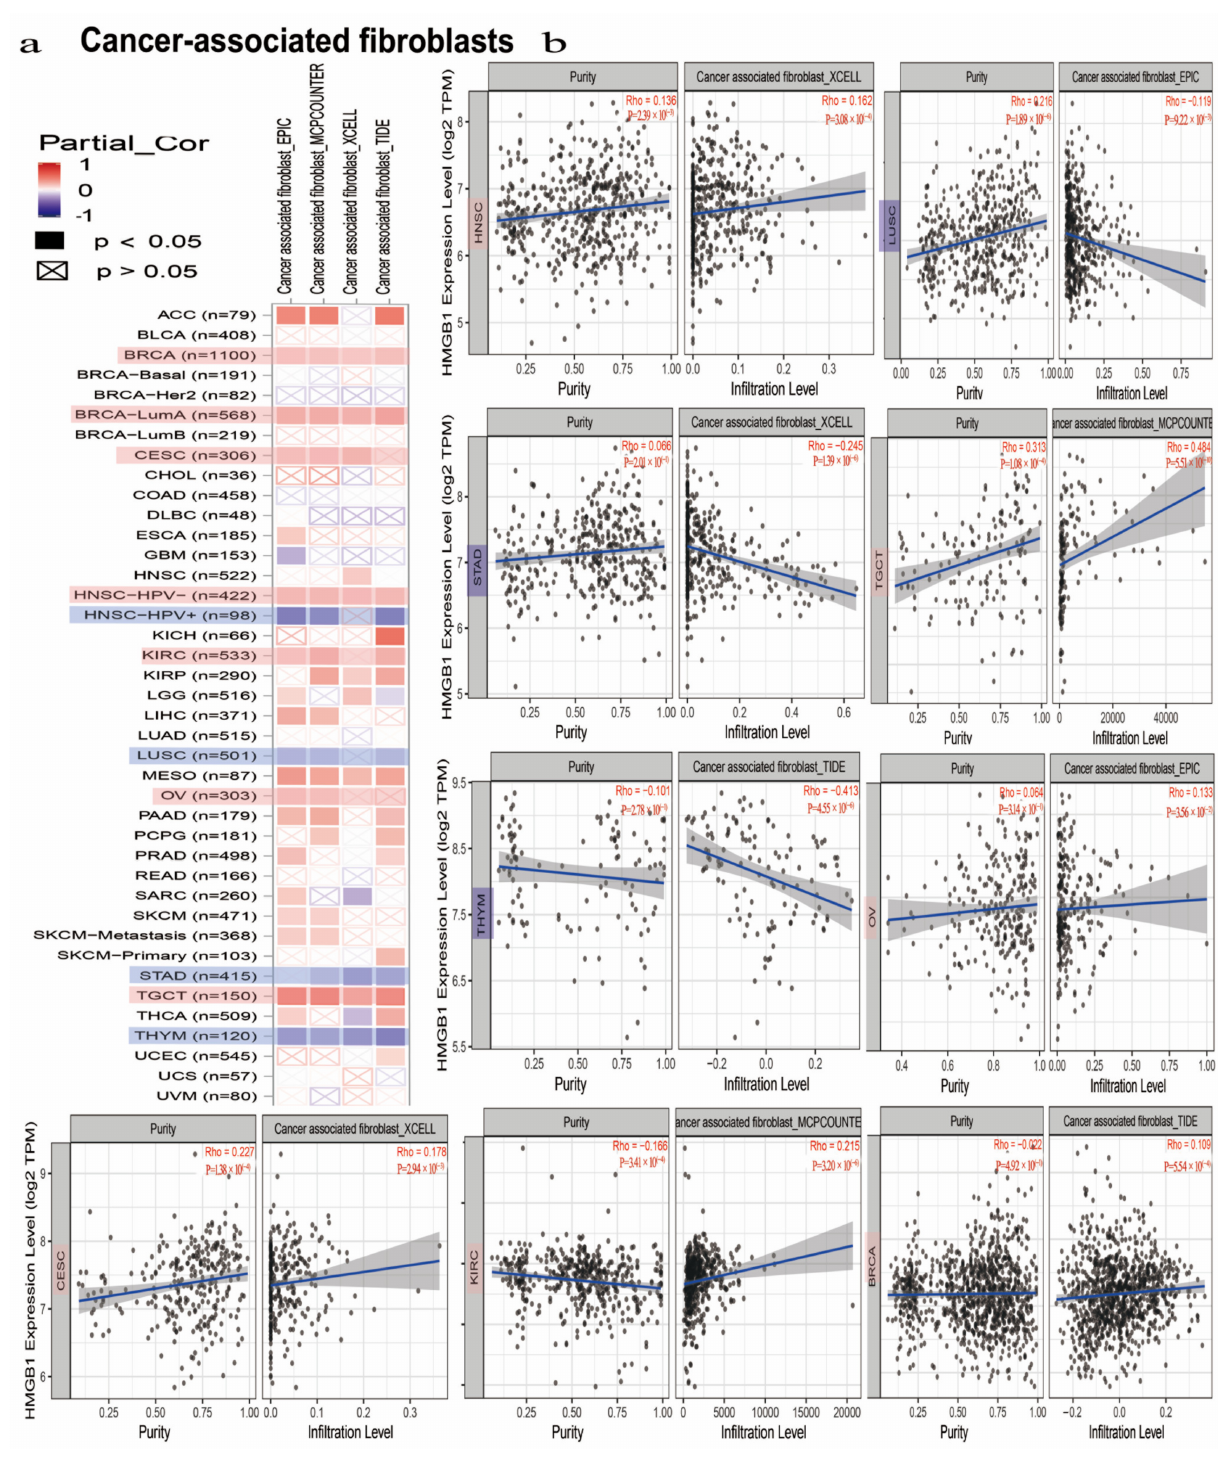
Figure 5. HMGB1 expression is closely linked with immune-infiltrated cancer-associated fibroblasts. ( a ) A heatmap of HMGB1 with immune-infiltrated level of cancer-associated fibroblasts in various cancers based on TCGA database. ( b ) A scatter plot of HMGB1 immune-infiltrated level of